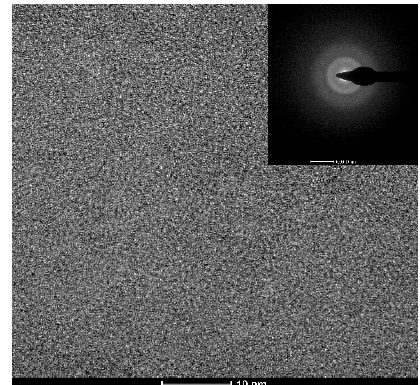
Figure 3. TEM bright field image with an SAED pattern for the 15 mm diameter Ti 45 Zr 20 Be 23 Co 12 rod.